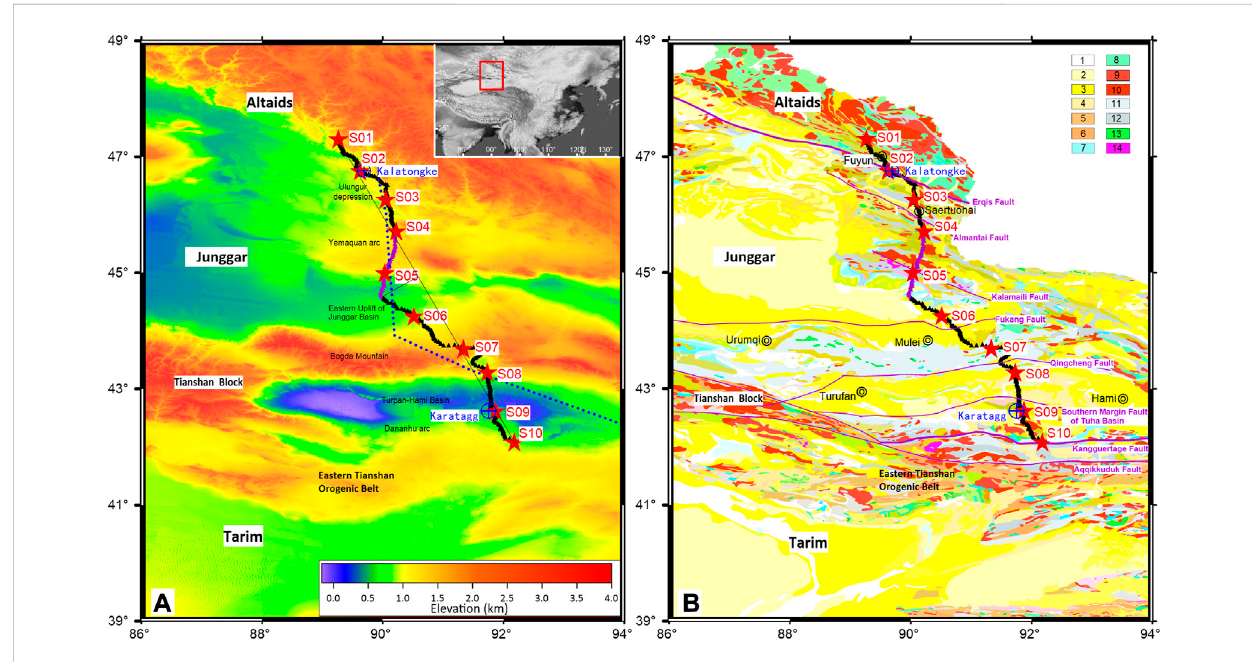
FIGURE 1 The topography (A) and geological setting (B) of Altai-Tianshan DSS pro fi le. Black triangles: EPS-type digital seismographs; purple triangles: PDS-2 type digital seismographs; red stars: shot point locations (S01-S10). The blue dashed line in Panel A denotes the location of old DSS line given by Wang etal.(2003)inthisregion.Thelithology inPanel B :1)Quaternary Holocenealluvialdeposits.2)UpperPleistoceneandHoloceneweatheredsedimentary. 3) Upper Pleistocene and Holocene water sedimentary. 4) Tertiary sedimentary. 5) Lower Proterozoic. 6) Middle Proterozoic. 7) Mesozoic. 8) Paleozoic. 9) Devonian-Permian granites and granodiorites. (10) Proterozoic granites and granodiorites. (11) Middle Carboniferous sedimentary and volcanic rocks. (12) Early Carboniferous andesites and basalts; (13) Gabbro and diabase. (14) Peridotite and diabase